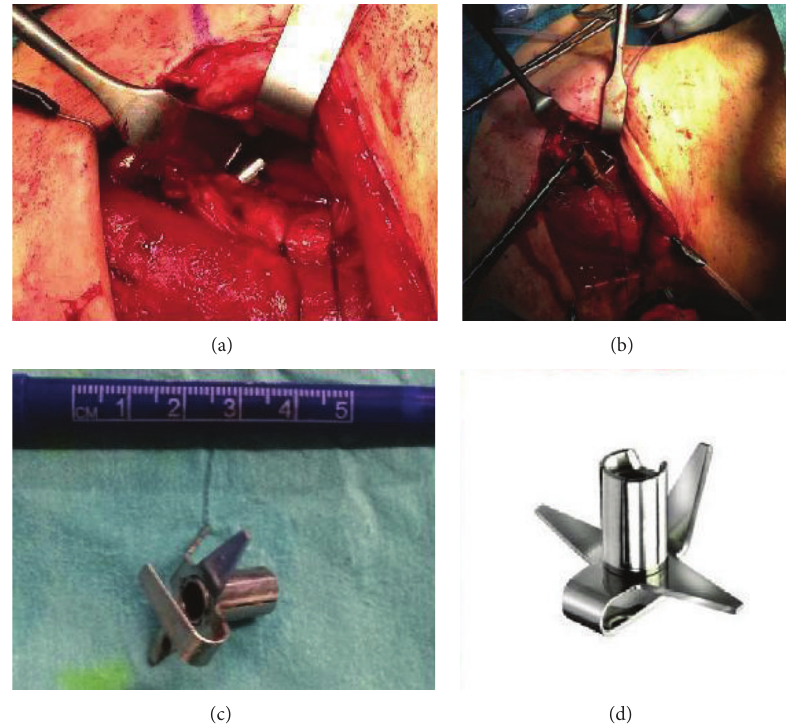
Figure 3: (a, b, c) Perioperative image, (d) Bamix, M´ezi`eres,